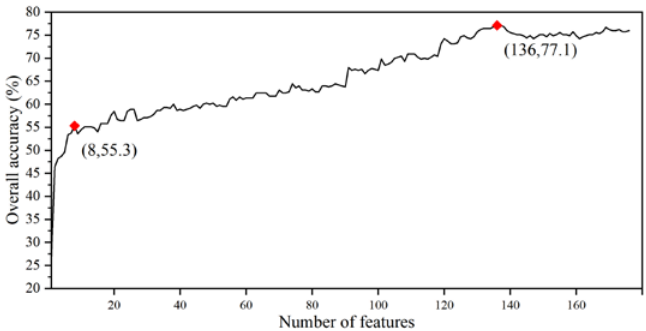
Figure 4. Relationship between the number of features and classification accuracy (Level II category).